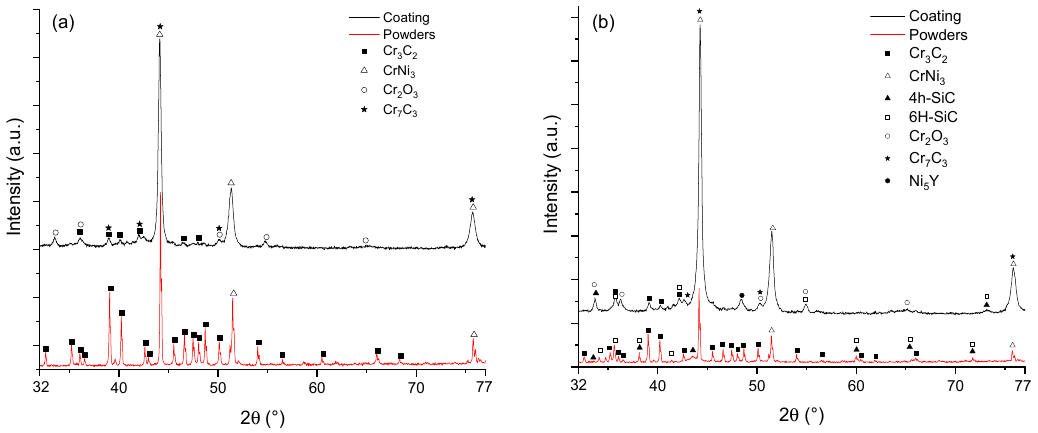
Figure 4. Diffraction patterns: ( a ) Cr 3 C 2 -NiCr and ( b ) SiC-NiCrAlY/Cr 3 C 2 -NiCr. Figure 4. Di ff raction pa tt erns: ( a ) Cr 3 C 2 -NiCr and ( b ) SiC-NiCrAlY/Cr 3 C 2 -NiCr.